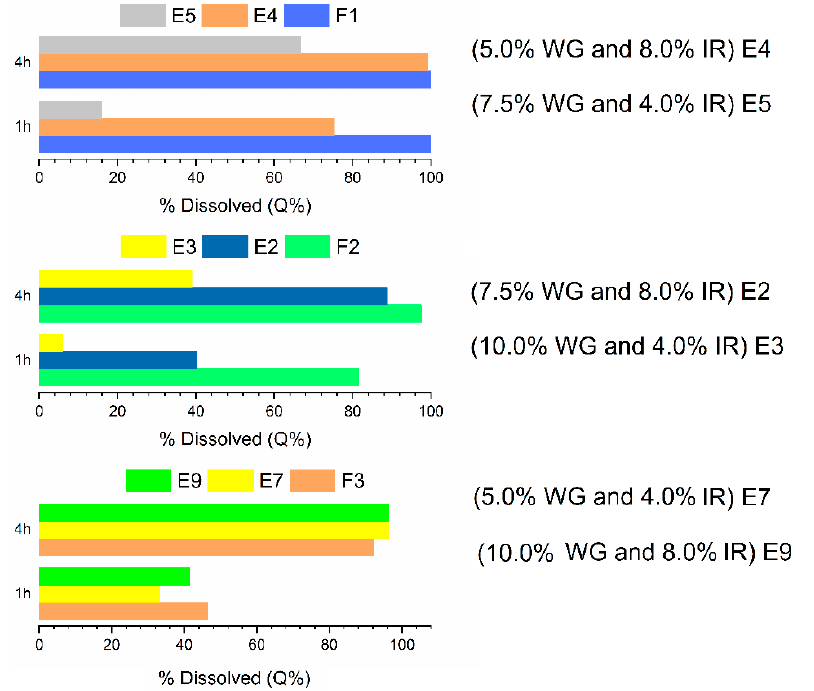
Figure 4. Comparison of Q% 1h and Q% 4h values of formulations F1, F2, and F3 before and after coatings. WG% and IR represent coating weight gain and Kollicoat ® IR, respectively.